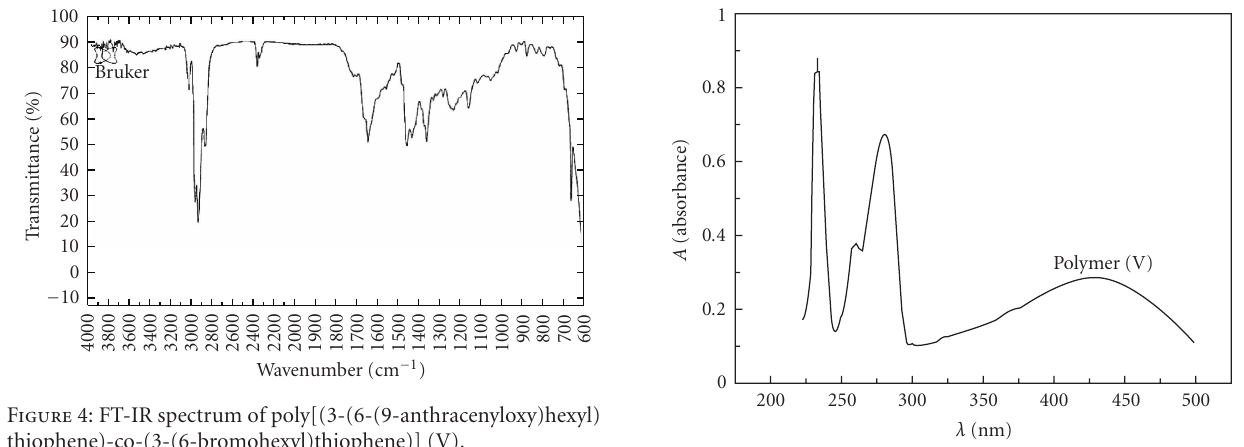
Figure 5: UV-Vis spectrum of copolymer (V) in CHCl 3